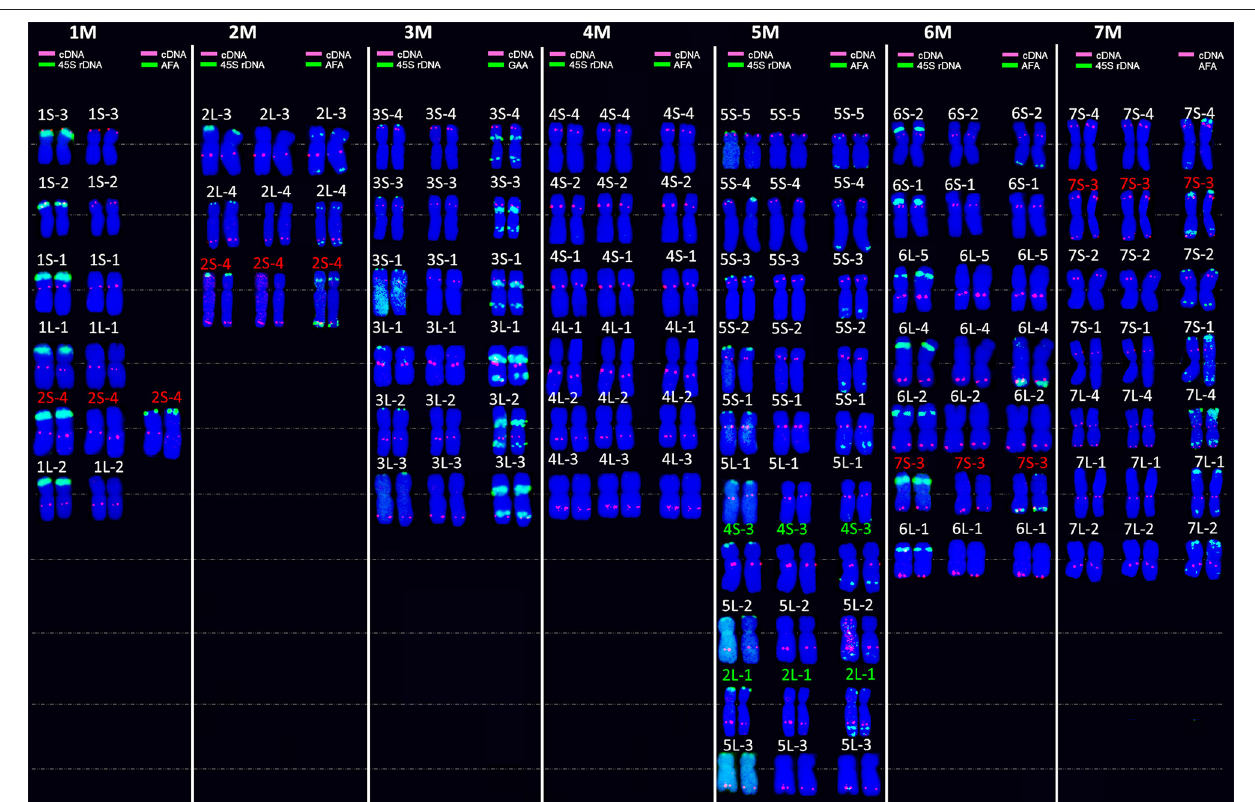
FIGURE 2 | FISH on mitotic metaphase chromosomes of Ae. comosa reveals the distribution of 43 wheat cDNA probes (red dots), in addition to 45S rDNA, Afa family repeat, and GAA microsatellites (all in green). Each chromosome pair (1–7M) is shown three times, with the patterns of the repeats in addition to cDNA (left and right of the column) and with the cDNA-probes only (middle of the column). The names of the cDNA probes are shown above each chromosome pair. The names of cDNA probes that hybridized to more than one chromosome are highlighted in red. The names of cDNA-probes that hybridized only to a non-homoeologous chromosome are highlighted in